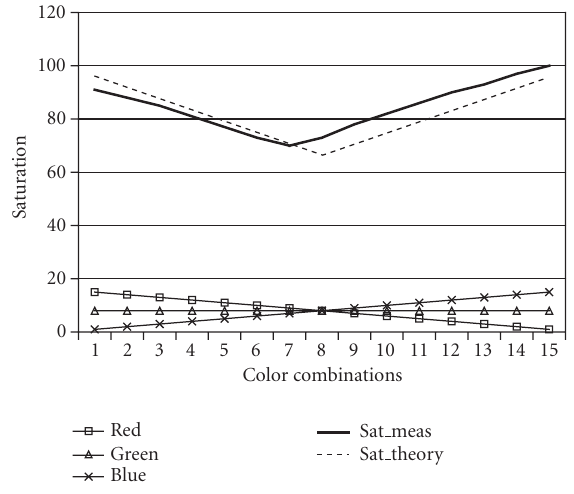
Figure 10: Measured saturation (S) as a function of rgb .